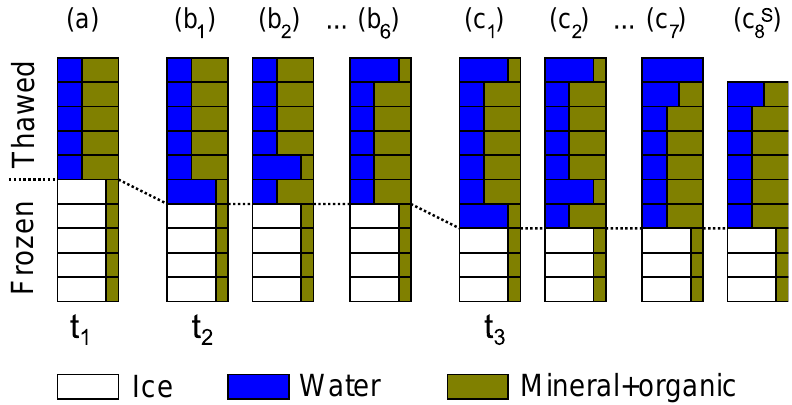
Figure 1. The scheme for thawing excess ground ice for an example with saturated ground conditions and equally spaced grid cells (with indicated fractions of ice, water and mineral): when a grid cell with excess ground ice thaws from time step t 1 to t 2 (a → b 1 ), excess water is successively moved upwards from grid cell, while the respective amounts of mineral and organics are moved downwards (b 1 → b 6 ). Following repeated thawing of excess ice grid cells, the uppermost grid cell consists entirely of water (c 7 ) and an initial pond has formed. In case of the subsidence scenario, such grid cells are removed (c S ) and the ground surface is 8